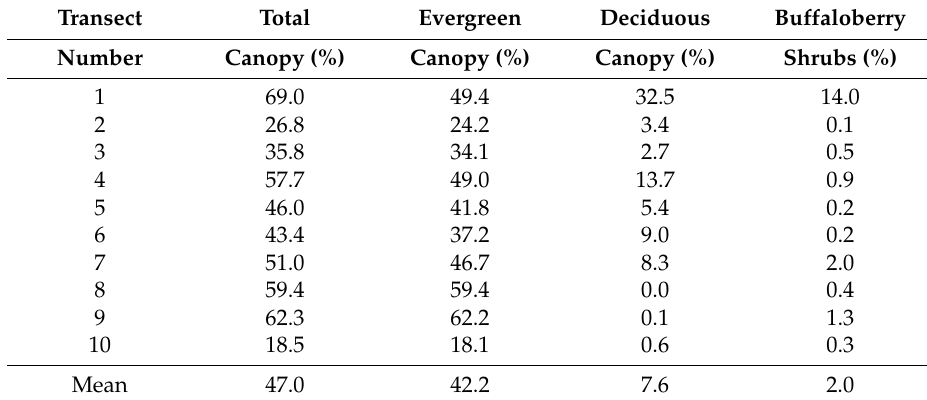
Table 2. Percentage of each transect covered by total, evergreen, and deciduous canopy, as well as buffaloberry shrub intercepts.